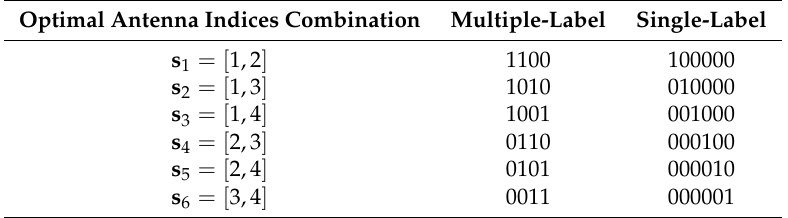
Table 1. Example of Multi-Label and Single-Label comparison with N T = 4 and L t = 2.